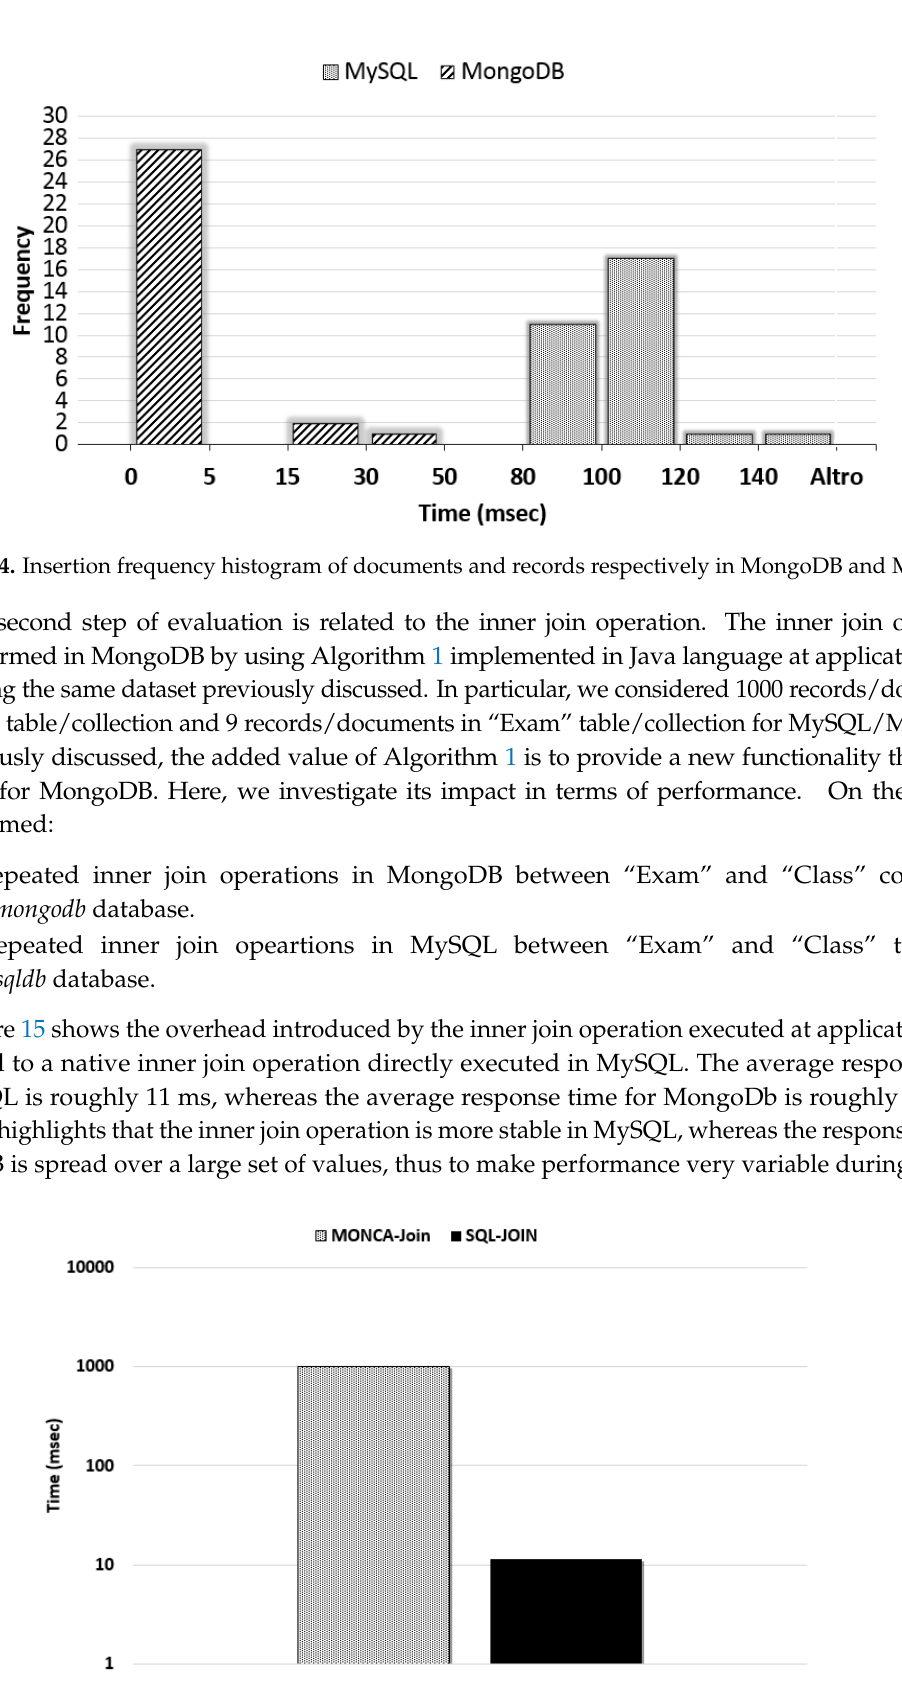
Figure 15. Average rensponse time comparison between MySQL and MongoDB (application-layer) join